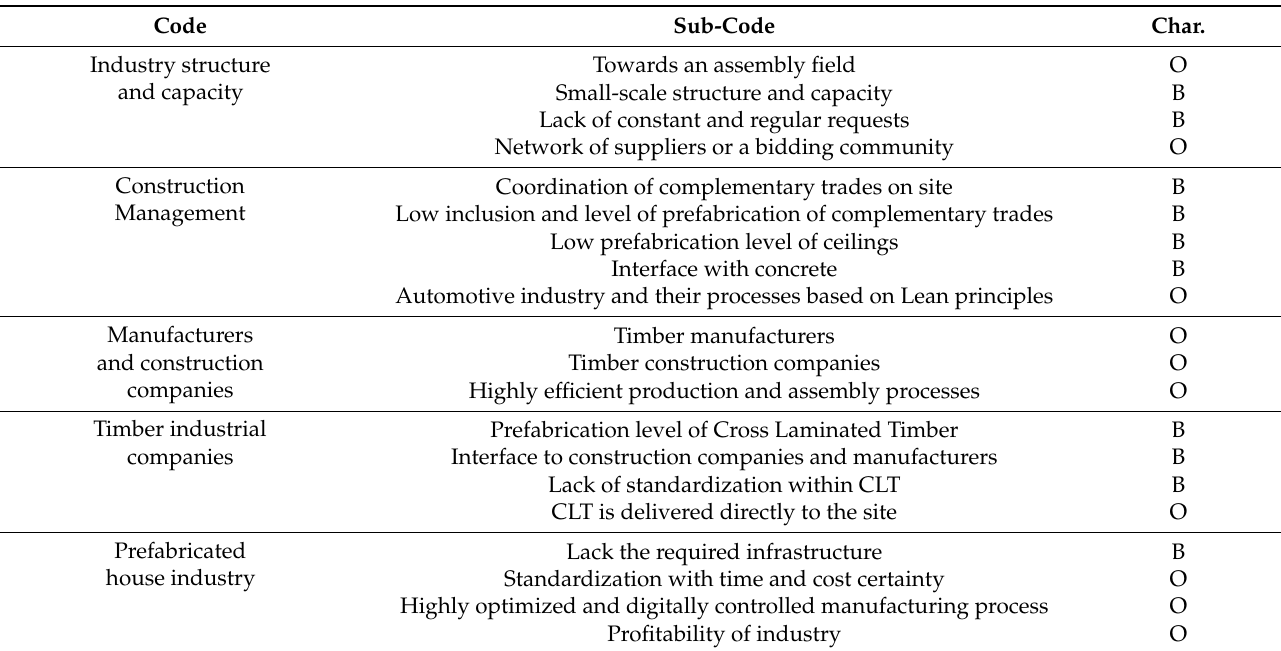
Table 6. Summary of codes in category Production and assembly with their embedded sub-codes and character according to their frequency of